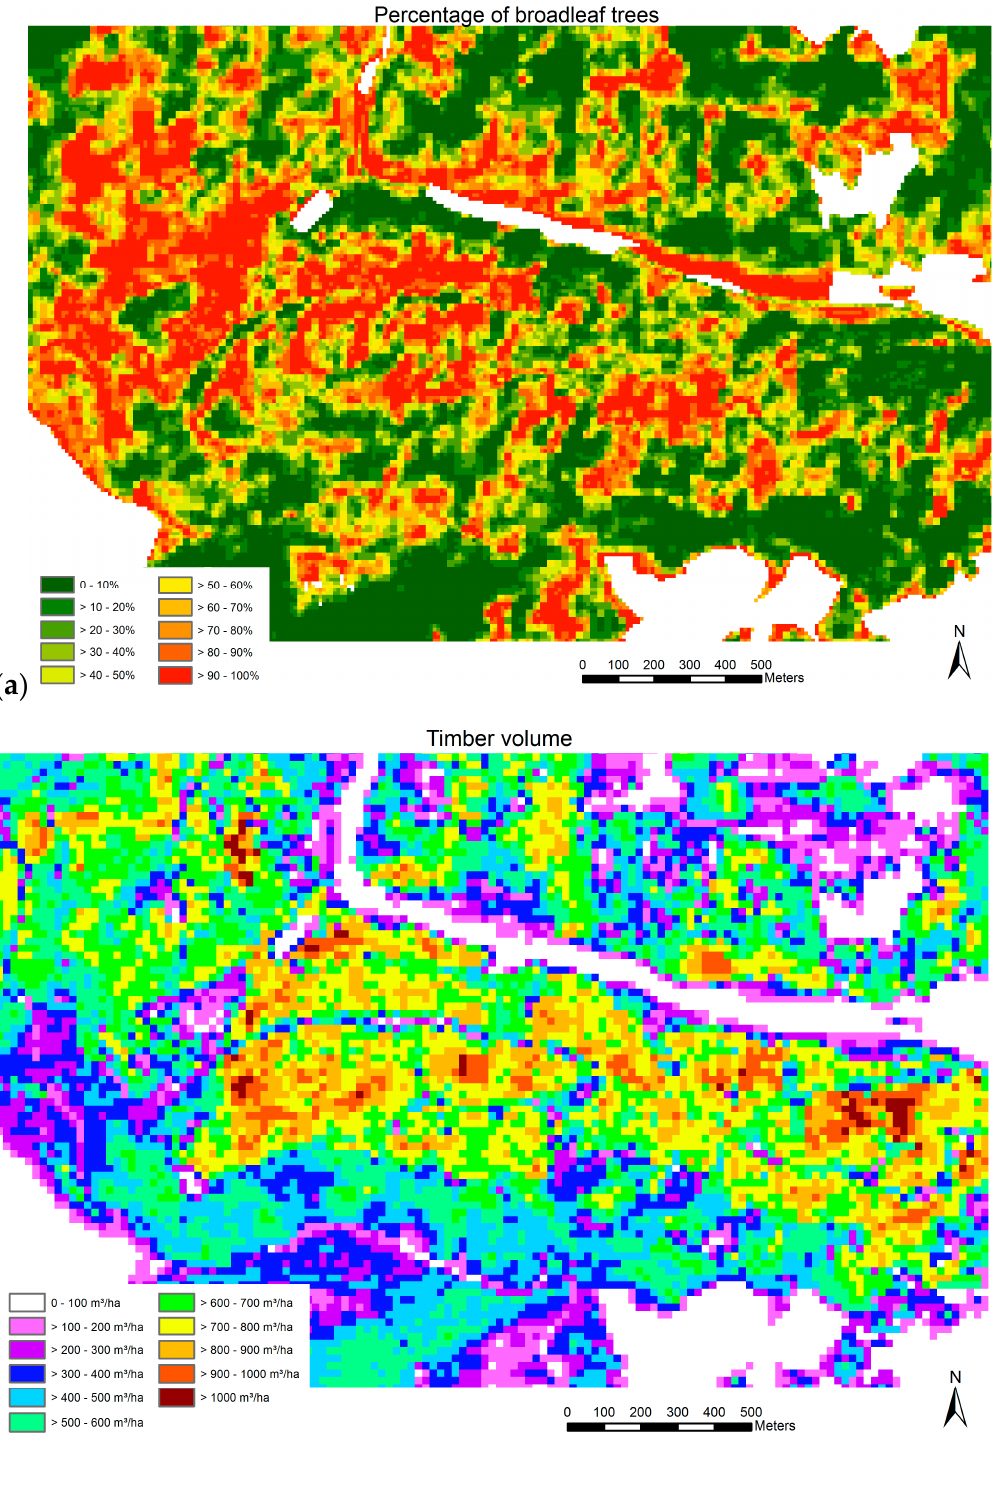
Figure 4. Close-ups of map predictions of ( a ) BL% and of ( b ) timber volume for the same